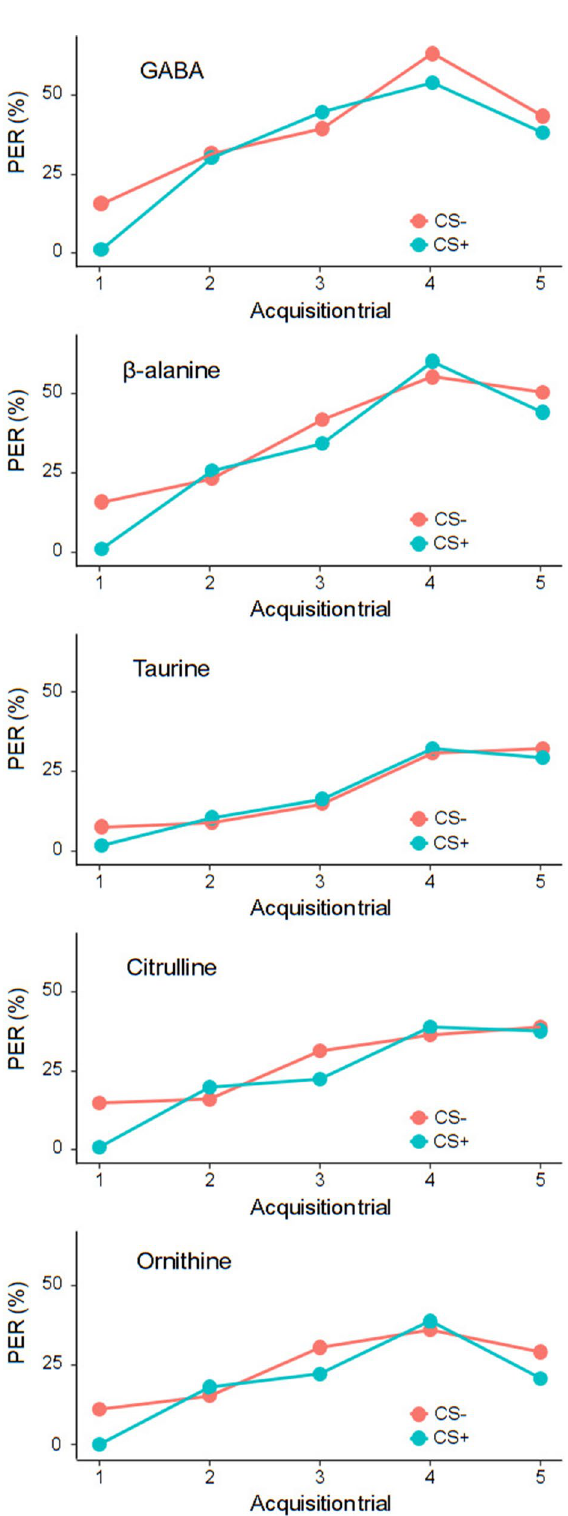
Figure 1. Honey bees are not able to detect NPAAs when using only their antennae. Proportion of bees showing a conditioned PER during the chemo-tactile conditioning assay. Blue lines represent PER to the reinforced stimulus (CS+). Pink lines represent PER to the punished stimulus (CS−). NPAA-laced water solutions and pure water were used as CS+ and CS−. No significant differences were found in the proportion of bees showing PER to the CS+ and the CS− for any of the NPAAs (GLMM, GABA: p = 0.08; β-ALA: p = 0.10; TAU: p = 0.65; CIT: p = 0.17; ORN: p =